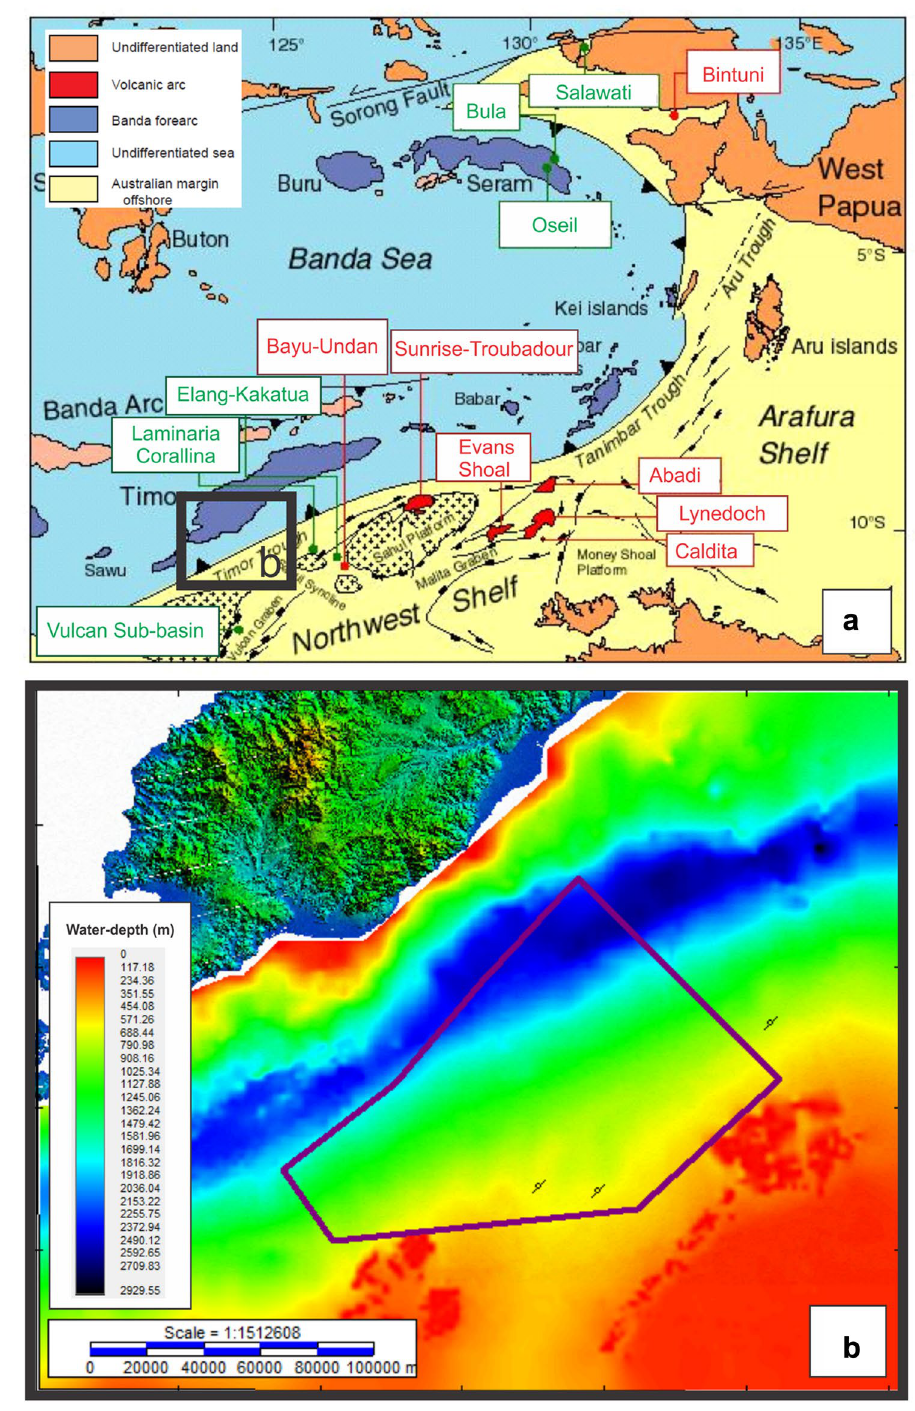
Fig. 1 a Regional tectonic setting of the Timor Sea and petroleum findings (following Charlton 2002). The black box is offshore western Timor. b Water depth map of the offshore western Timor, with the study area inside the